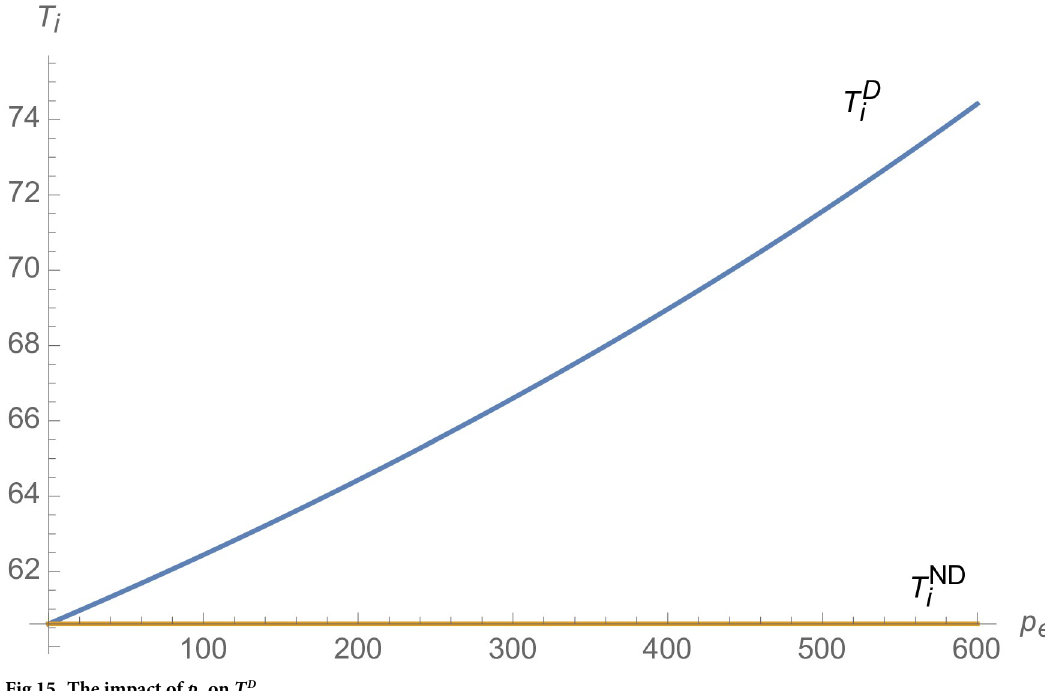
Fig 15. The impact of p e on T D